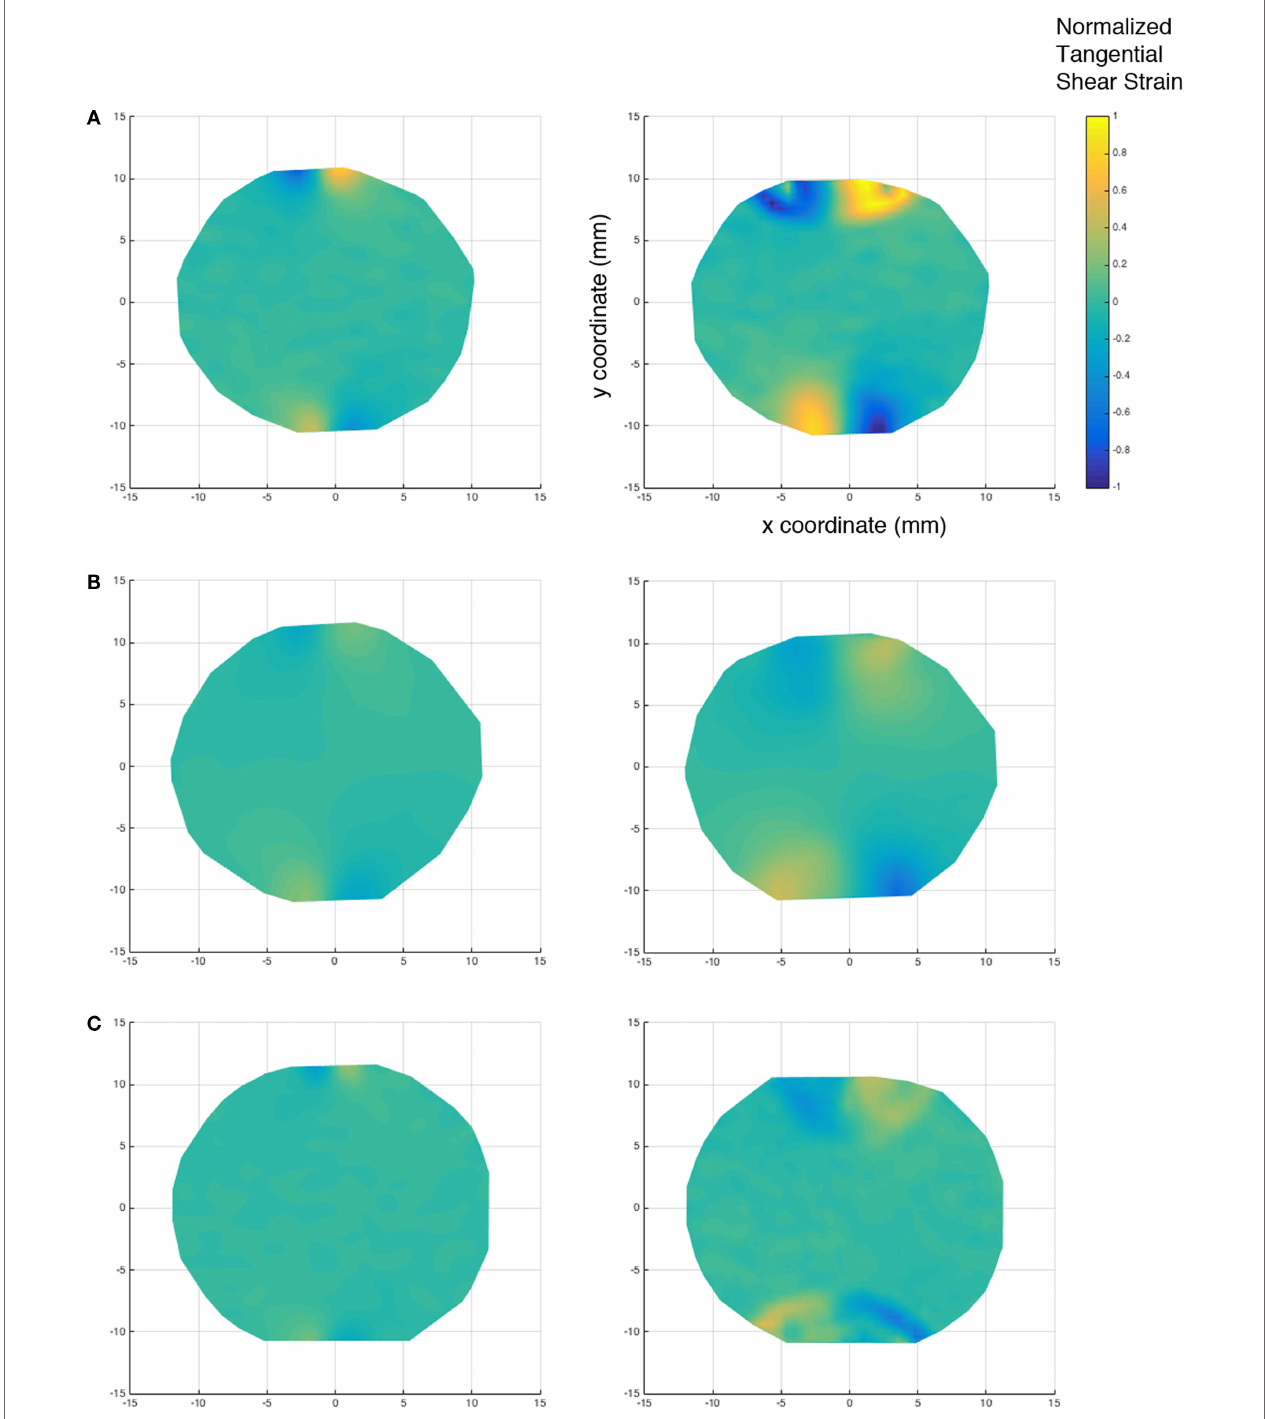
FIGURE 5 | DIC results of shear strain in the elastic region (left column) and before failure (right column) for (A) pure aluminum, (B) Al–5%Al 2 O 3 , and (C) Al–5%GNP .